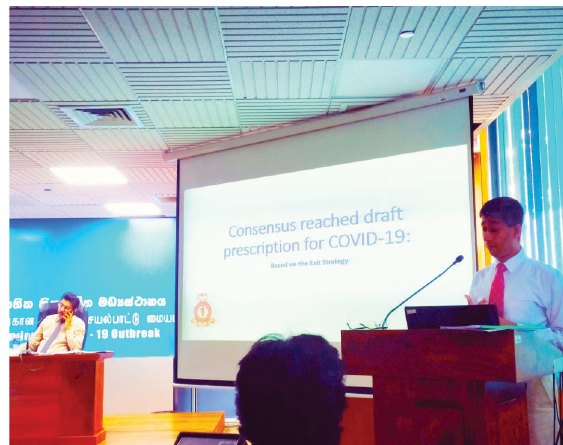
Figure 2: Presenting the Exit Strategy